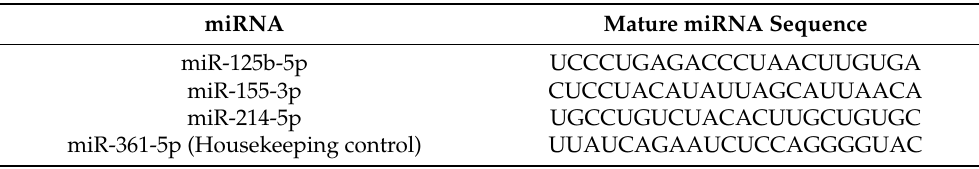
Table 3. Sequences of analysed